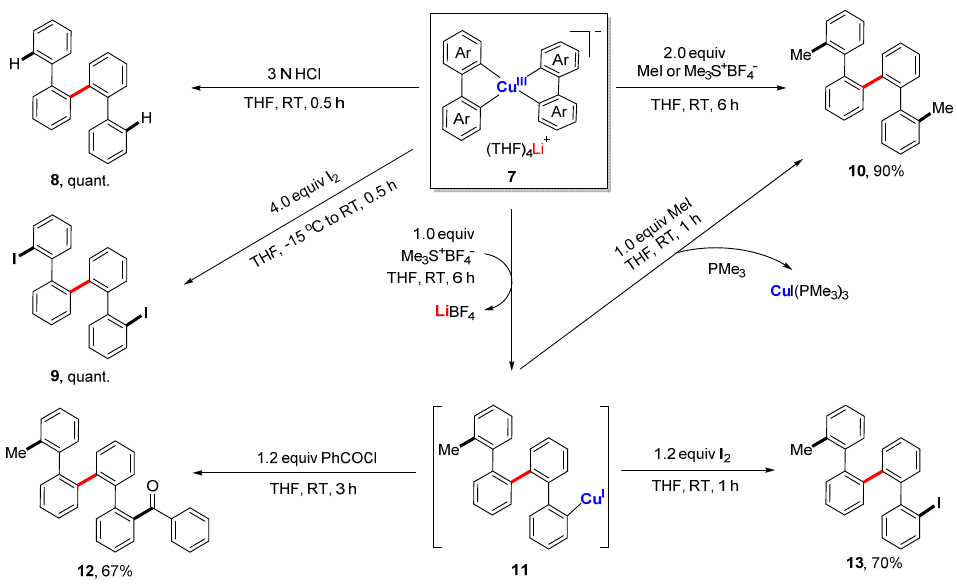
Scheme 3. Reductive elimination of organometallic spiro Cu(III) complexes.